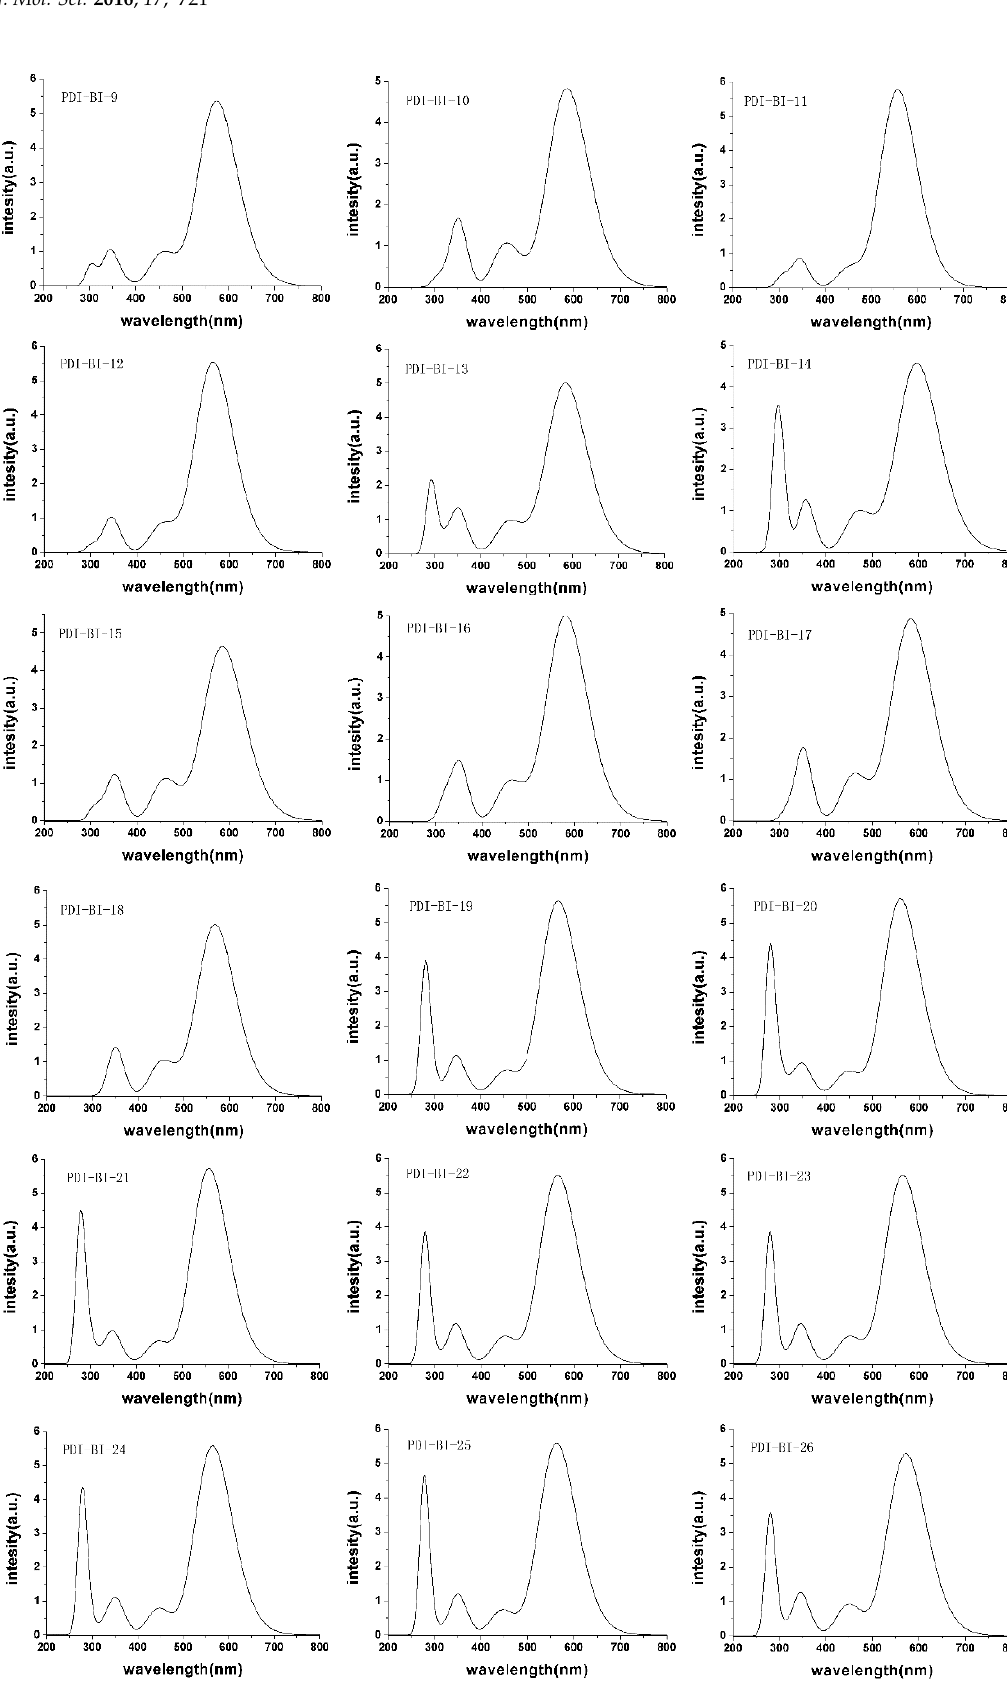
Figure 5. The calculated absorption spectra of PDI-BI and its derivatives (value of full width at half maximum is 3000 cm − 1 ).